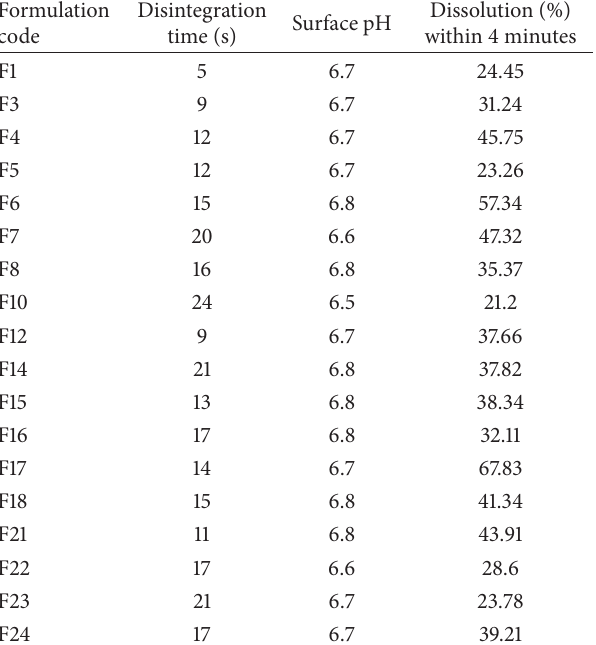
Table 5: In vitro disintegration test, surface pH test, and in vitro dissolution test of OS loaded with